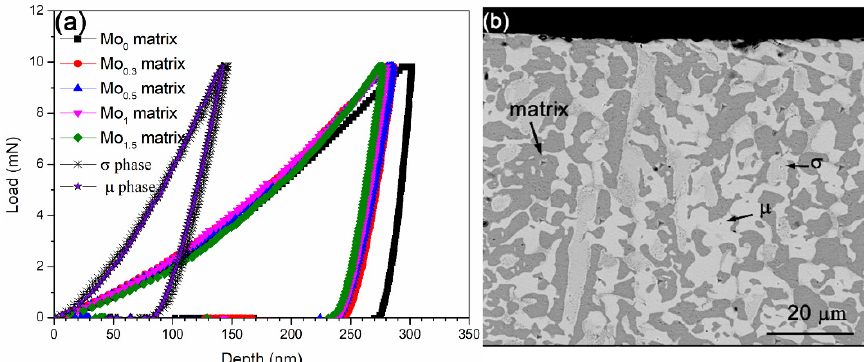
Figure 5. ( a ) Load-depth curves for the FCC solid solution, σ and μ phases in the Mo x HEA for the maximum load of 10 mN and ( b ) a given SEM backscattering image of these indents for Mo1. Table 3. The nano-hardness of the prepared materials in different phases.